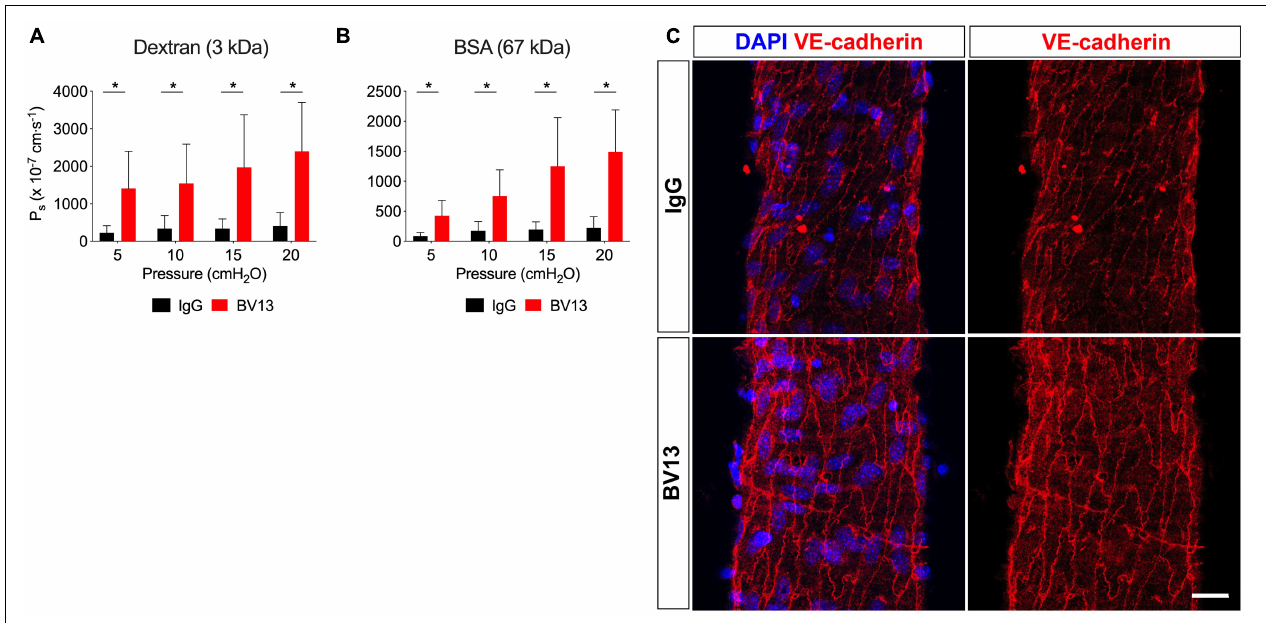
FIGURE 4 | VE-cadherin regulates collecting lymphatic vessel solute permeability (P s ). Collecting lymphatic vessels were perfused with either isotype control antibody (IgG) or a VE-cadherin function blocking antibody (clone: BV13, 100 µ g/mL). (A) P s to 3 kDa dextran in the presence of IgG antibody (black bars) or following treatment with BV13 antibody (red bars) ( n = 5). (B) P s to BSA in the presence of IgG (black bars) or following treatment with BV13 (red bars) ( n = 5). (C) Collecting lymphatic vessels perfused with IgG or BV13 (100 µ g/ml) were fixed and stained for DAPI (blue) and VE-cadherin (red). All graphs show mean ± SD and each “ n ” refers to a different mouse. *, P < 0.05 by two-way ANOVA. Scale bar is 20 µ